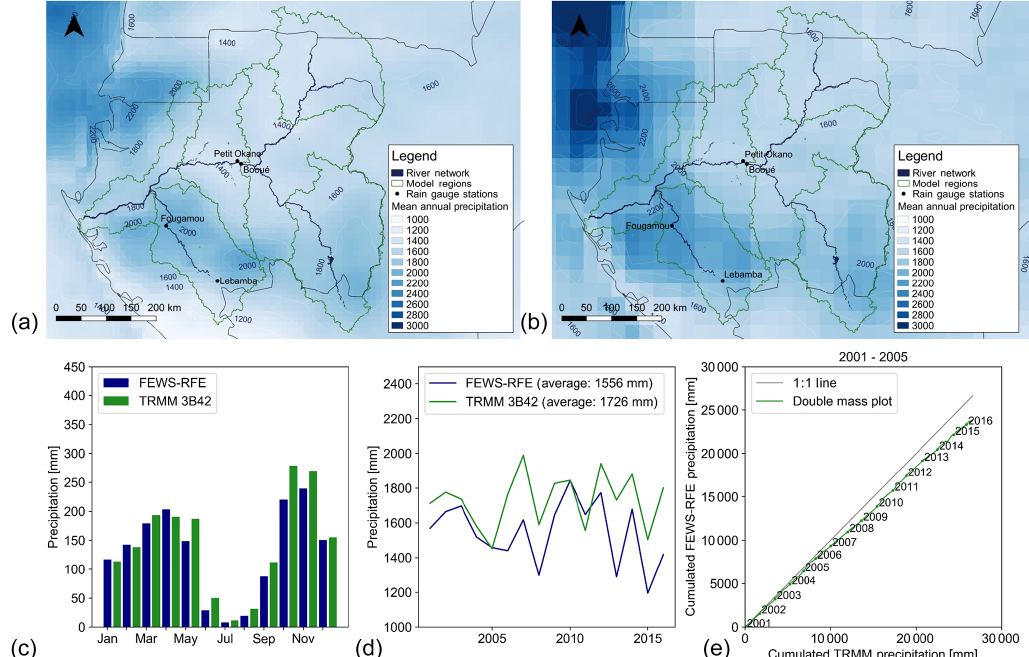
Figure 2. Average annual precipitation in the Ogooué basin based on FEWS-RFE (a) and TRMM 3B42 v7 (b) , long-term monthly aver- age (c) and annual average (d) precipitation from TRMM 3B42 v7 and FEWS-RFE v2, and double mass plot (e)